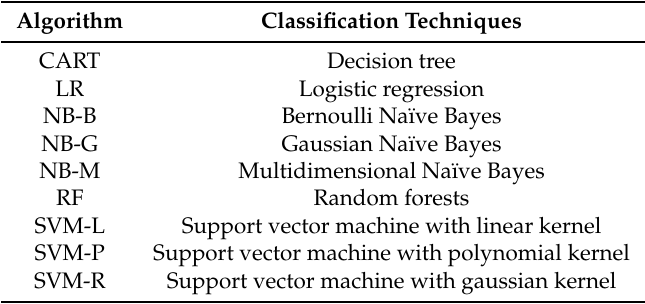
Table 4. Applied machine learning